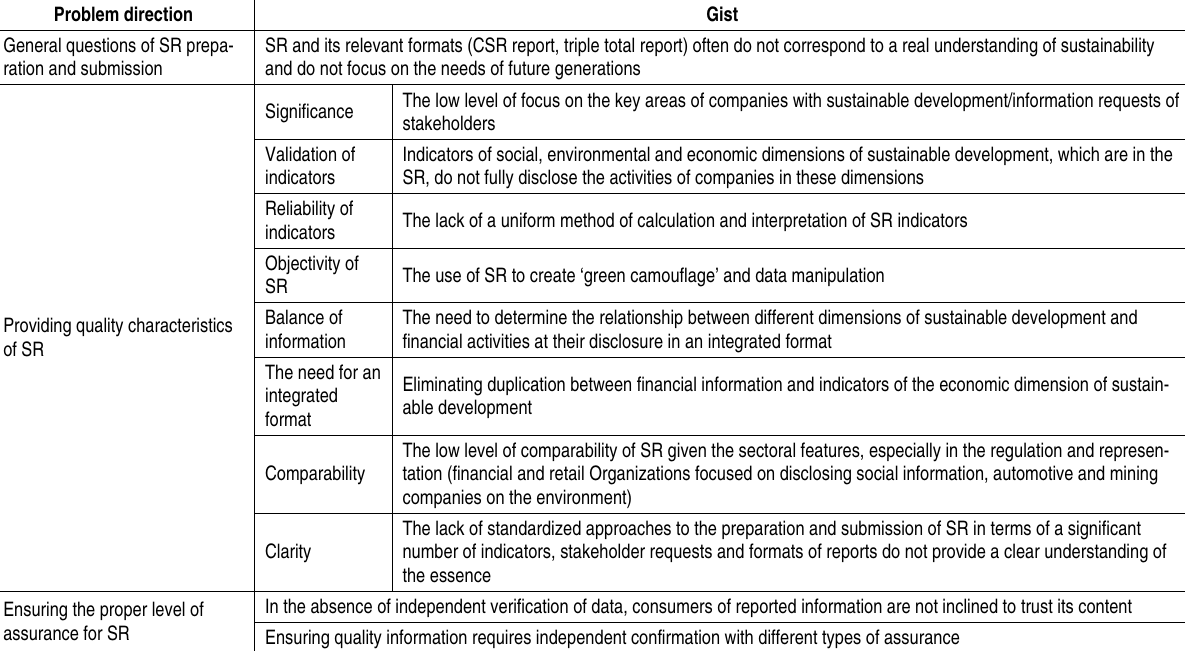
Table 1 (cont.). Problematic areas of SR presentation